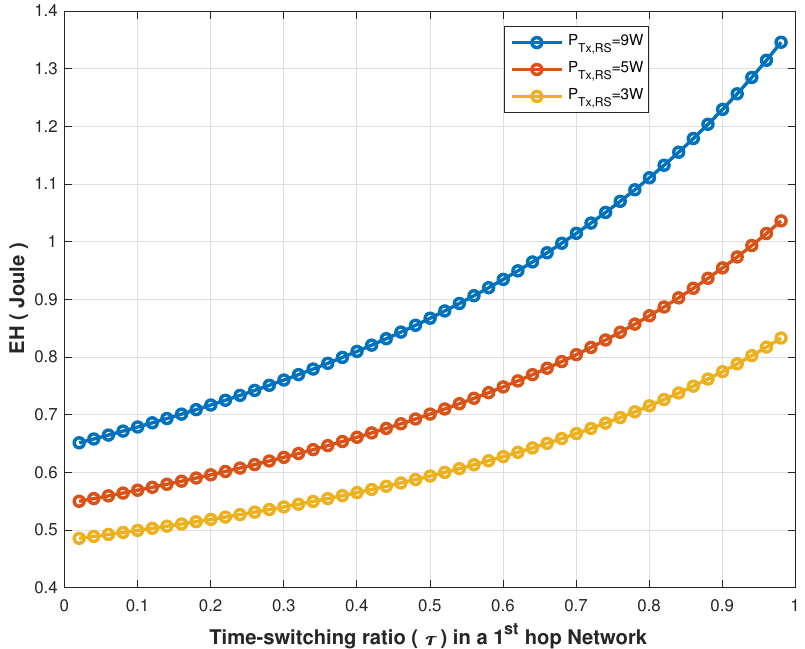
Figure 11. EH performance vs. time switching ratio ( τ ) at different P Tx , RS values.